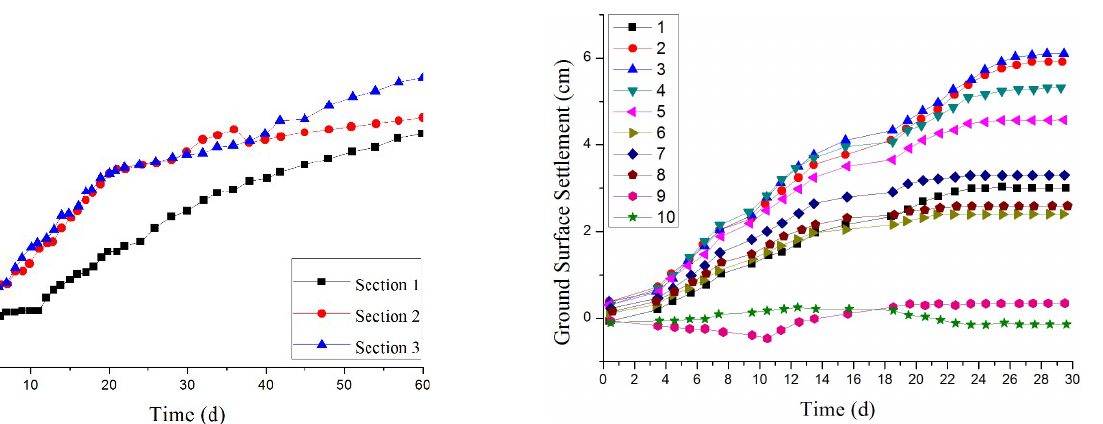
Figure 17. Settlement–time curve of the vault supported by the bench method with the composite cantilever support structure.